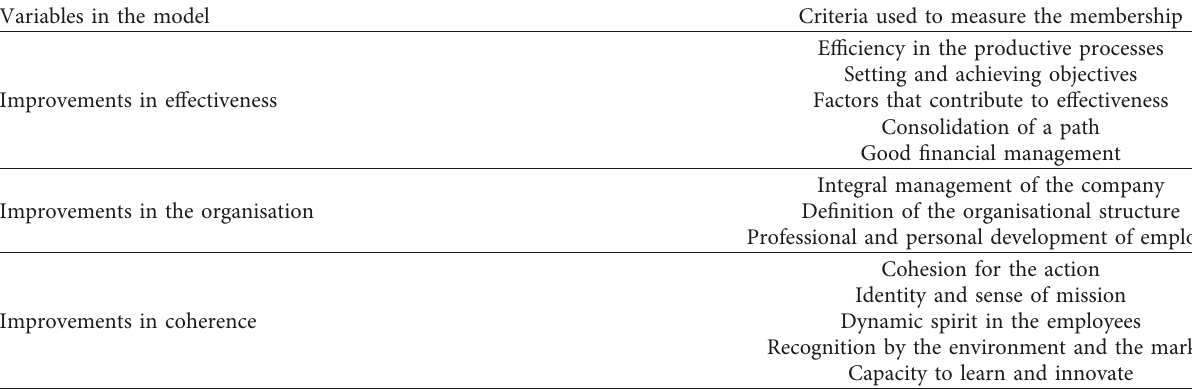
Table 3: Elements used to set measurements on the proposed